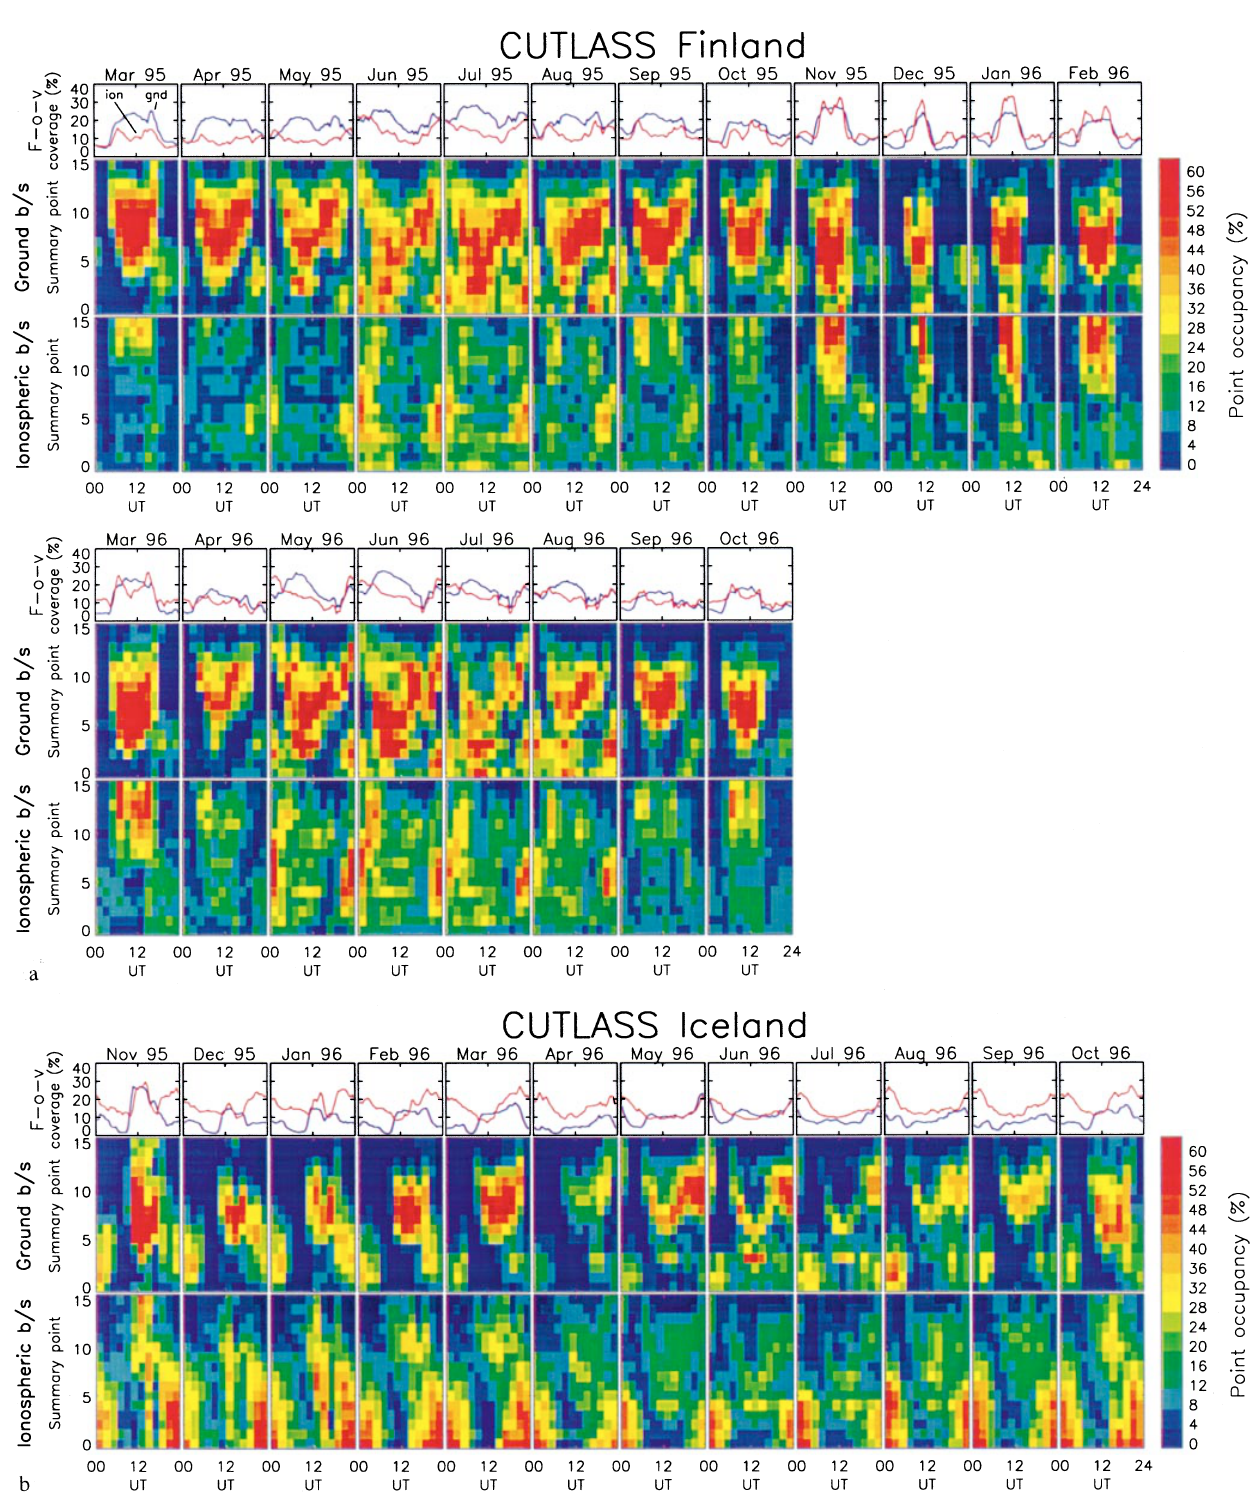
ground and ionospheric backscatter for the months March 1995 to June 1996. b Iceland radar. Similar to a , though for months